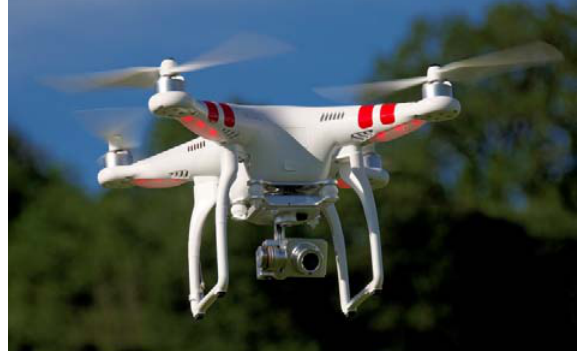
Figure 1. Micro UAV DJI Phantom 2 Vision Plus (URL 1) A test field of 105 evenly distributed points was used for testing and the calibration of images (Figure 2). Coordinates of the test field were determined by the space intersections taken from more occupation-points measured by the total station Leica TCR705. The achieved accuracy of the coordinates of the test field is ± 0.1 mm.